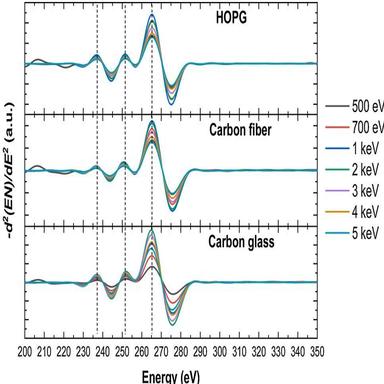
Negative second-order differentiation of AES spectra of HOPG, carbon fiber and carbon glass.